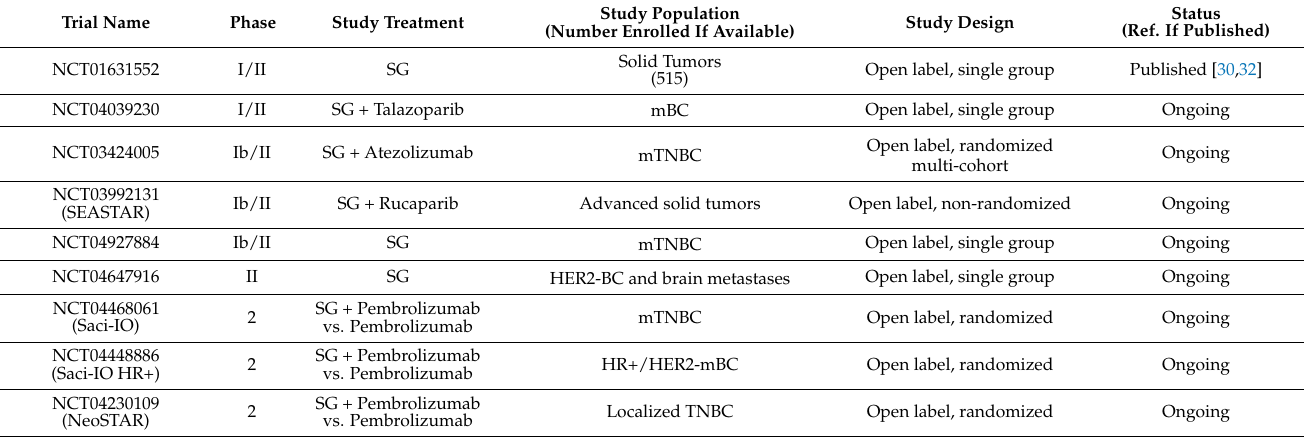
Table 1. Selected published and ongoing trials testing Sacituzumab govitecan in breast